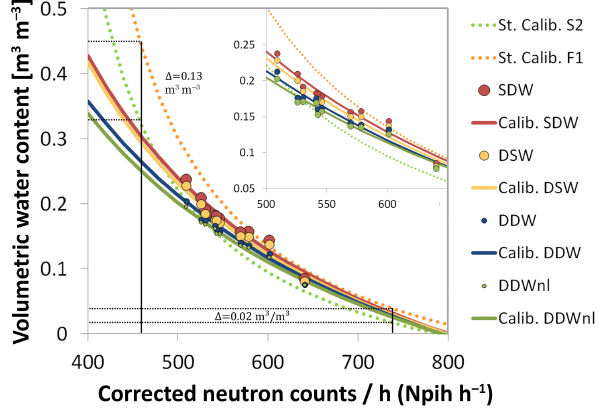
Figure 5. Modified calibration functions (solid lines) for the four different weighting approaches (simple depth weighting SDW, depth-specific weighting DSW, distance–depth weighting DDW, distance–depth weighting, nonlinear DDWnl), each one derived from 10 calibration points (circles). Calibration points are better captured by flatter calibration functions (solid lines) with modi- fied calibration parameters than by any of the standard calibration functions (dotted lines) based on a single calibration data set only (days S2 and F1 as an example). Black lines illustrate that differ- ences in soil moisture between the results of individual calibrations are larger when soil moisture is high. The inset magnifies the area around the calibration